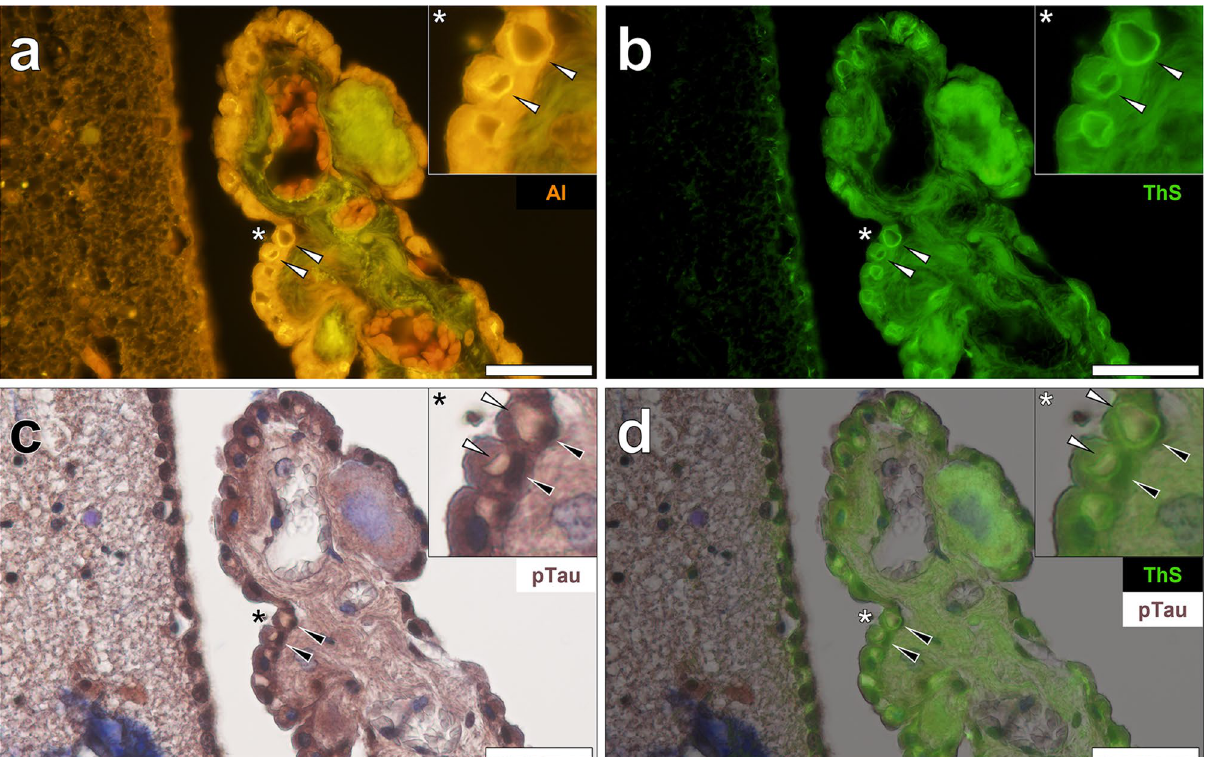
Figure 1. Biondi ring tangles (white arrows) in the choroid plexus adjacent to the hippocampus of a 60-year- old male donor with epilepsy. ( a ) Aluminium (Al) positive (orange) tangles in epithelial cells also produced ( b ) thioflavin S (ThS) fluorescence (green). ( c ) AT8 immunoreactive phosphorylated tau (pTau, black arrows) was deposited in the same cells lining the choroid plexus and was predominantly contained in cell nuclei. ( d ) Merging of the ThS channel revealed pTau and Biondi tangles in the same cells. Asterisks denote magnified inserts. Magnification: × 400, scale bars: 50